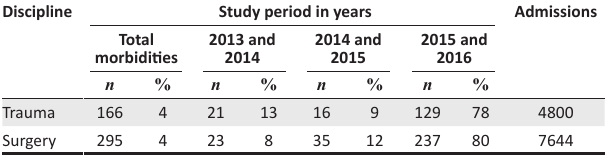
TABLE 2: Nursing-related morbidities by discipline.